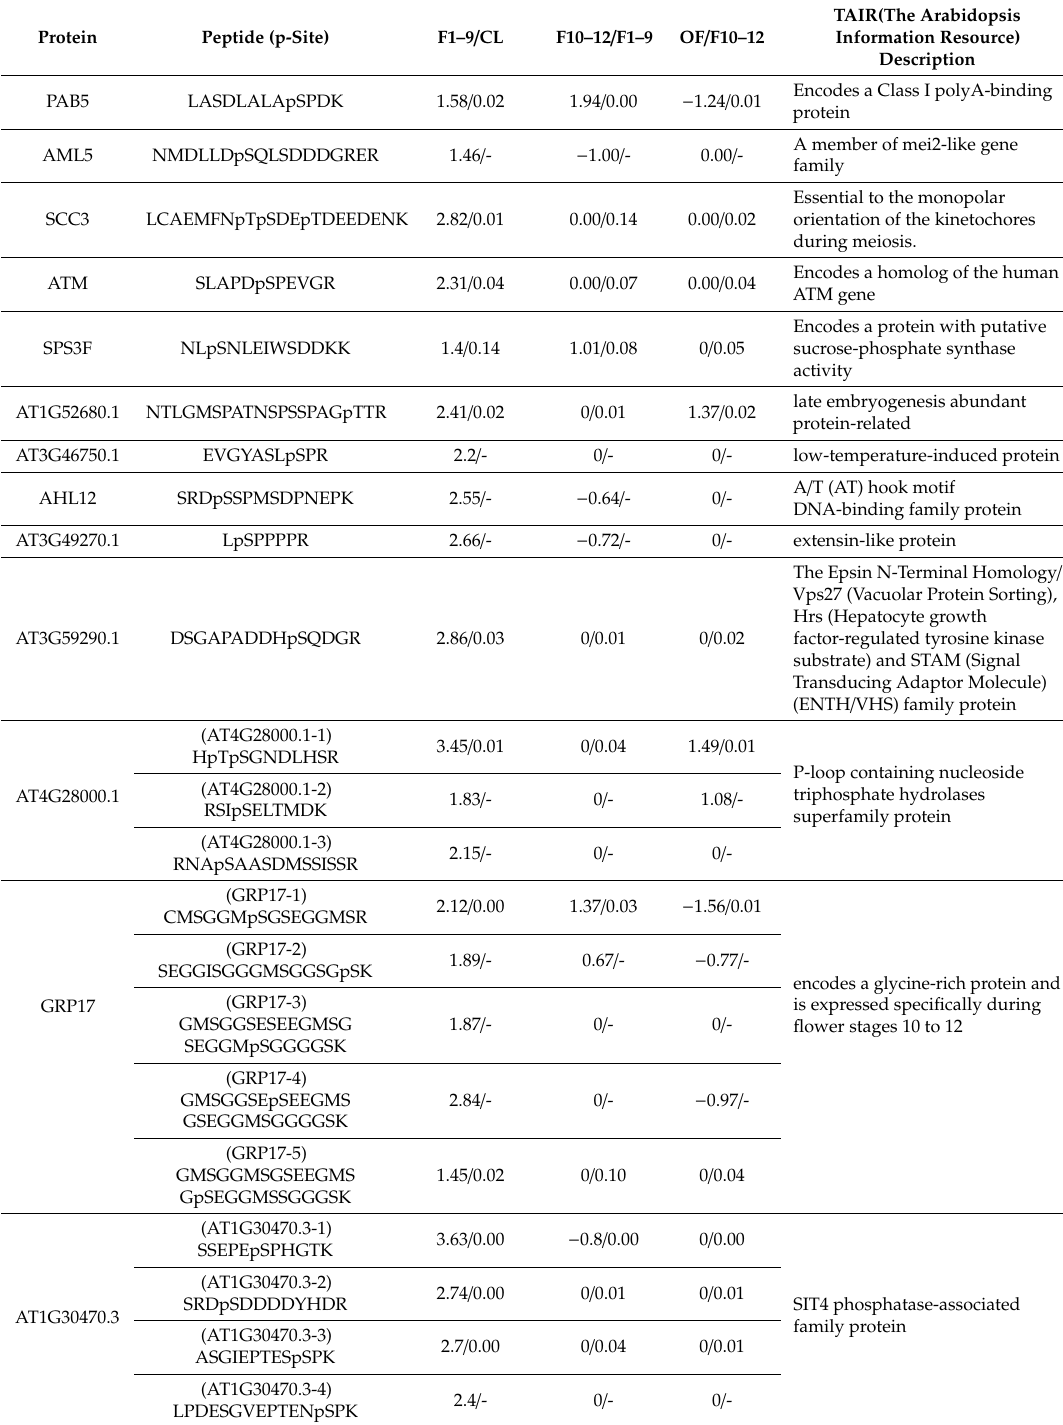
Table 1. Comparison of di ff erent phosphor-peptides belonging to anther-, meiosis-, and pollen-related proteins in di ff erent organ /